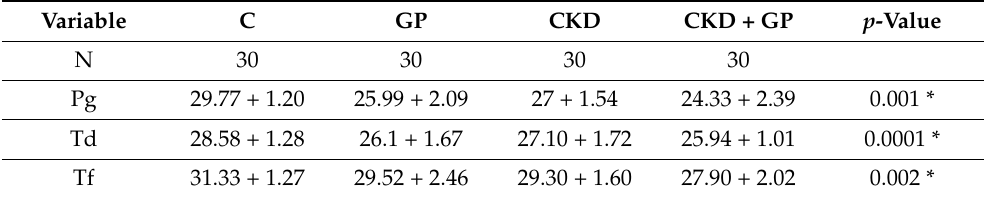
Table 6. Intergroup comparison of CT values of red-complex bacteria among C, GP, CKD, and CKD + GP Groups. Variable C GP CKD CKD + GP